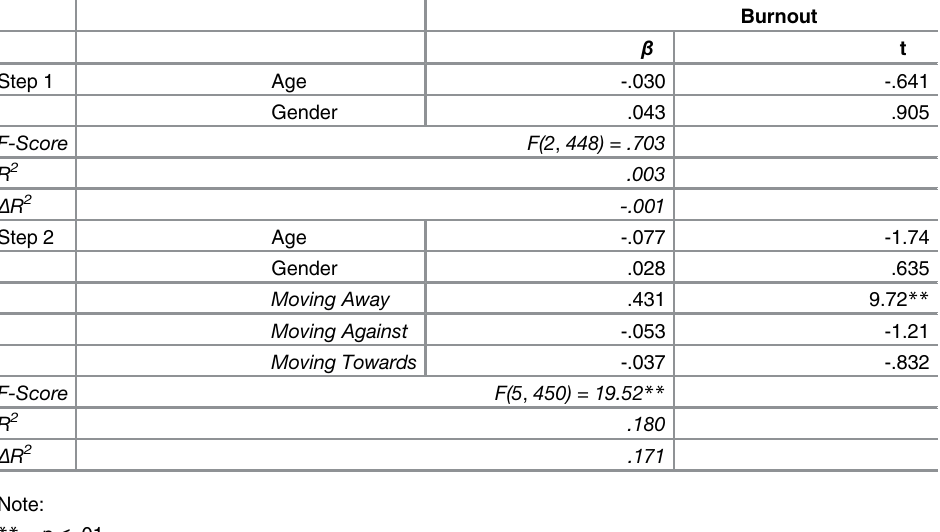
Table 5. Regression of Age, Gender, and three higher-order HDS Dark Side facets as predictors of CBI work-related Burnout.